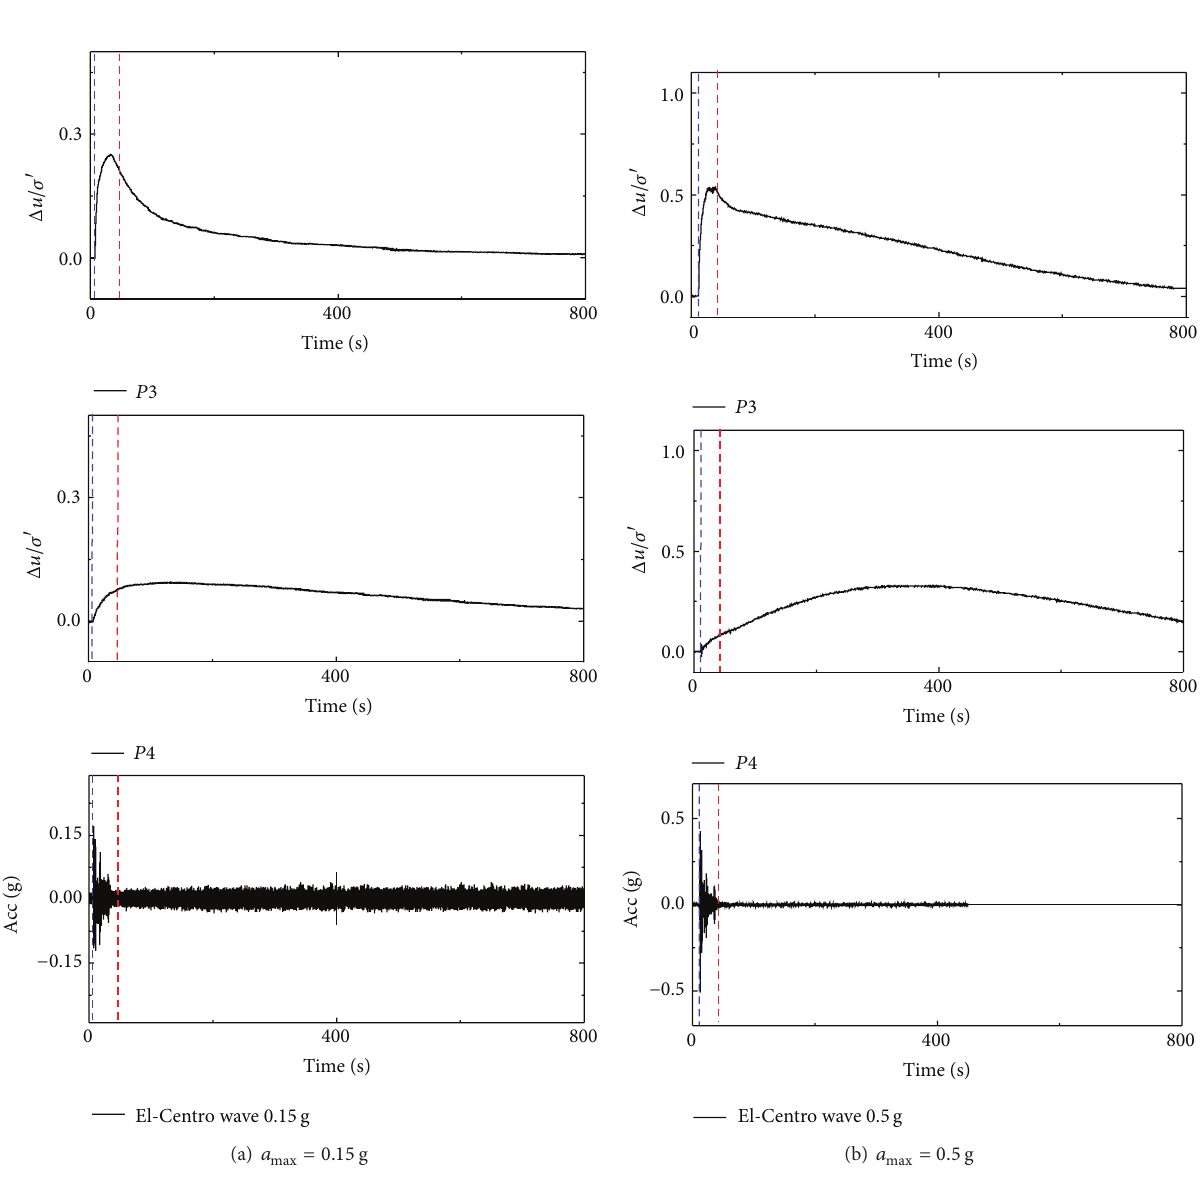
Figure 4: Pipe response of Δ𝑢/𝜎 󸀠 in test 1 under El-Centro